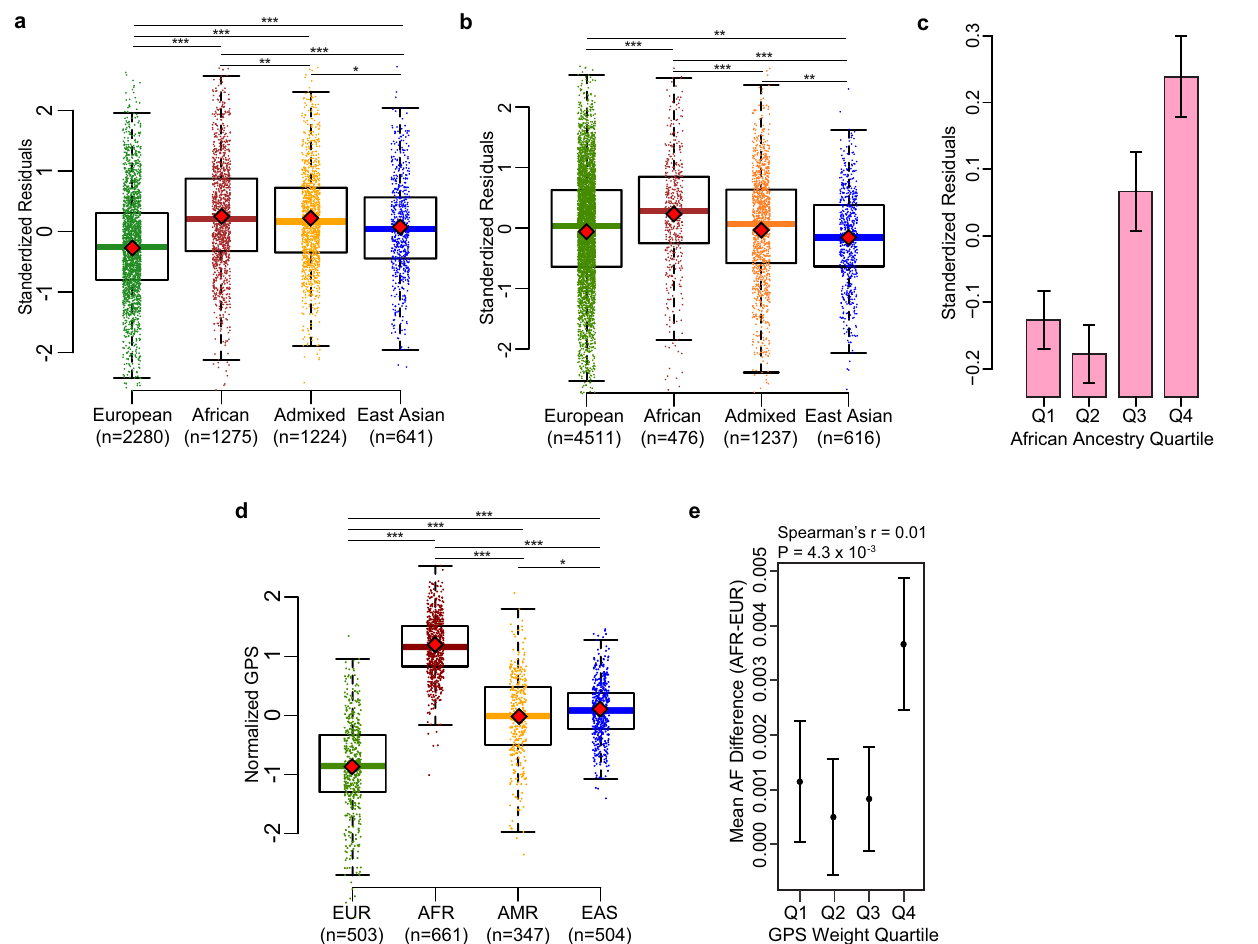
Fig. 1 | Ancestral differences in serum IgA levels. a discovery analysis across the four major ancestral groups in MESA demonstrates that African ancestry is asso- ciated with higher adjusted IgA levels, b replication analysis in all non-MESA study participants con fi rms higher mean IgA levels in individuals of African ancestry, c mean adjusted IgA levels (±95% con fi dence intervals) as a function of African ancestry fraction, demonstrating that individuals in the upper quartile (>75%) of African ancestry have the highest serum IgA levels ( N = 5420 MESA participants); standardized residuals generated by regression of log-transformed serum IgA levels against age and sex were signi fi cantly correlated with the African ancestry fraction ( P = 4.6 × 10 − 33 ), and this relationship remained highly signi fi cant after additional adjustment for BMI and diabetes ( P = 3.7 × 10 − 23 ), The boxplots in